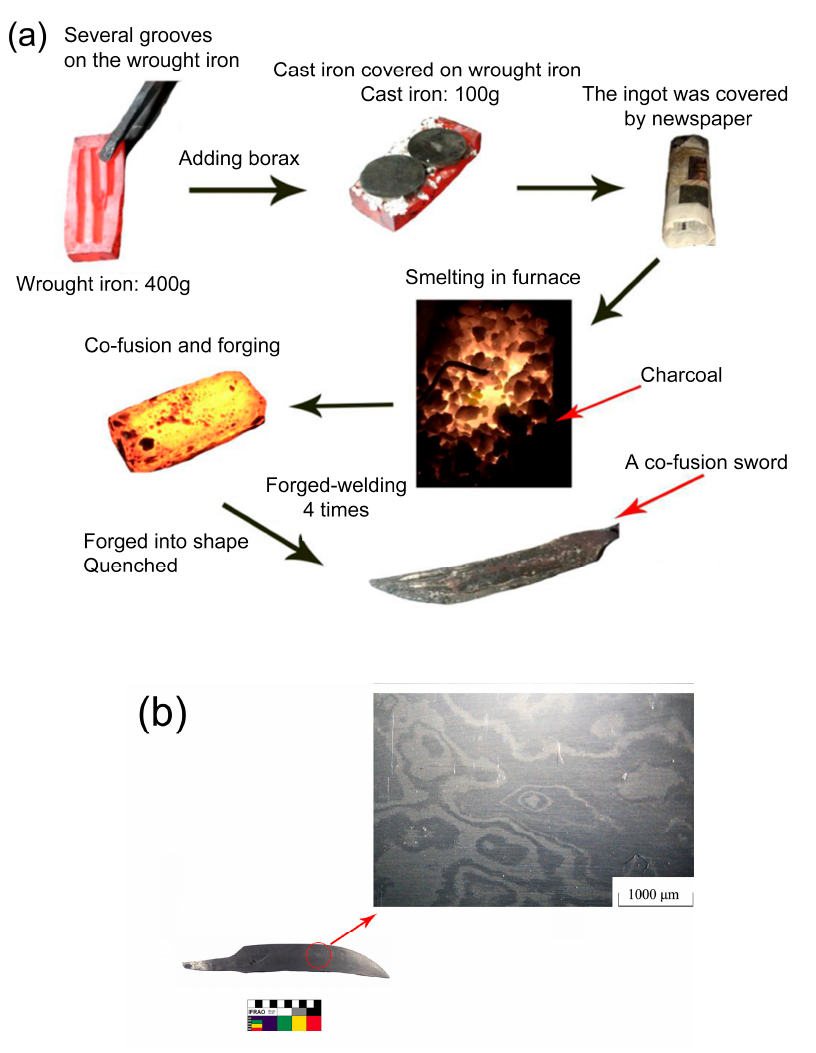
Figure 2. Cast iron covered on wrought iron to make swords: ( a ) technological process; ( b ) the sword and pattern on the surface.